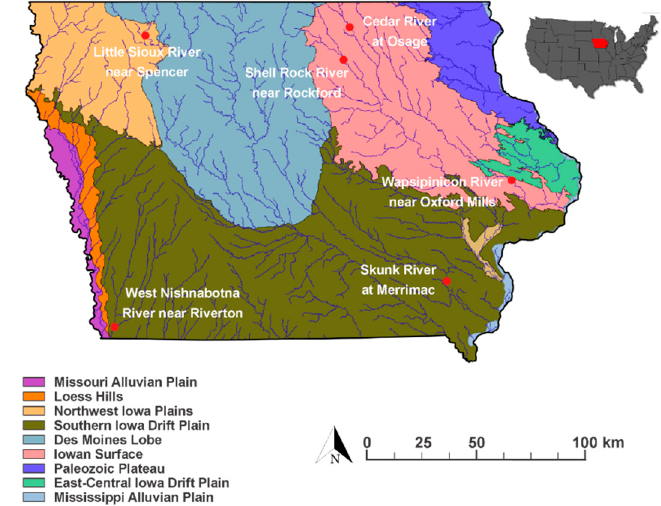
Figure 1. Map of the study area. The red dots show the six USGS gauges in Iowa analyzed in this study. The polygons indicate the landforms of Iowa.